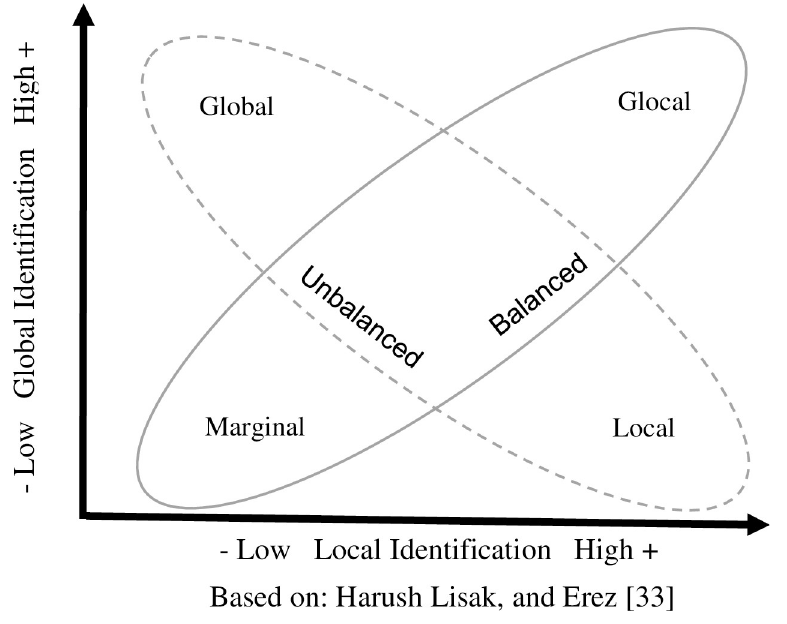
Fig 1. Extended global acculturation